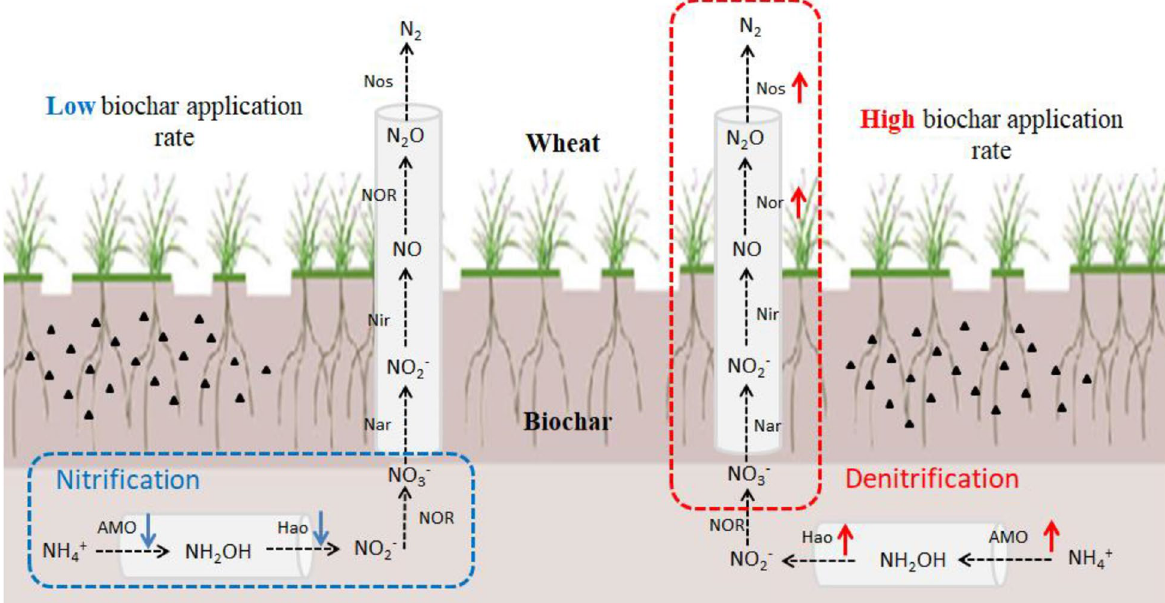
Fig. 5 Biochar regulation mechanism on soil nitrogen availability. AMO: Ammonia monooxygenase; Hao: Hydroxylamine oxidoreductase; NOR: Nitrite oxidoreductase; Nar: Nitrate reductase; Nir: Nitrite reductase; Nor: Nitric oxide reductase; Nos: Nitrous oxide